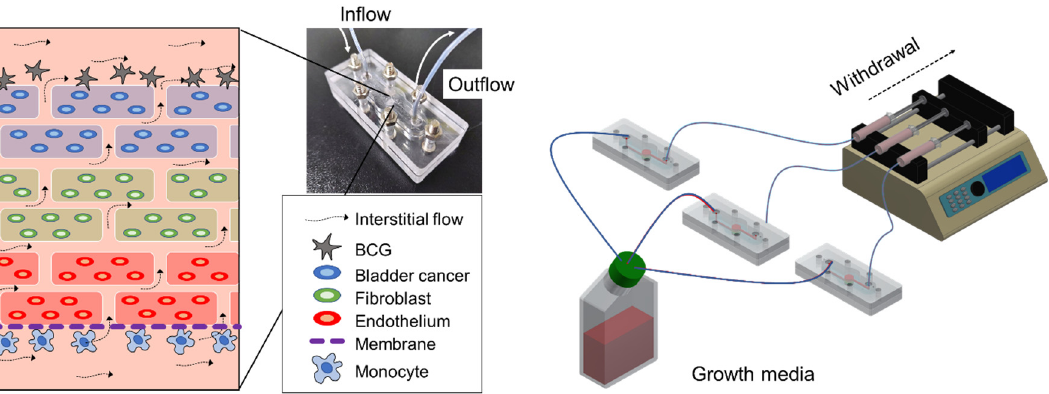
Figure 6. Schematic representation of three-dimensional bioprinted bladder cancer-on-a-chip with microfluidic system using Bacillus Calmette–Guérin.